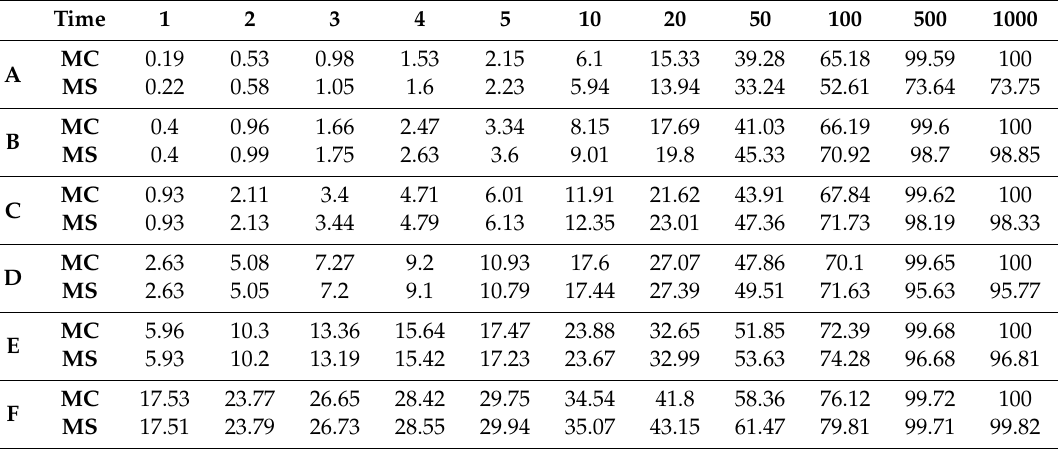
Table 8. Estimated transition probabilities to default. Comparison of MC and MS models with 1 < t < 1000 (%